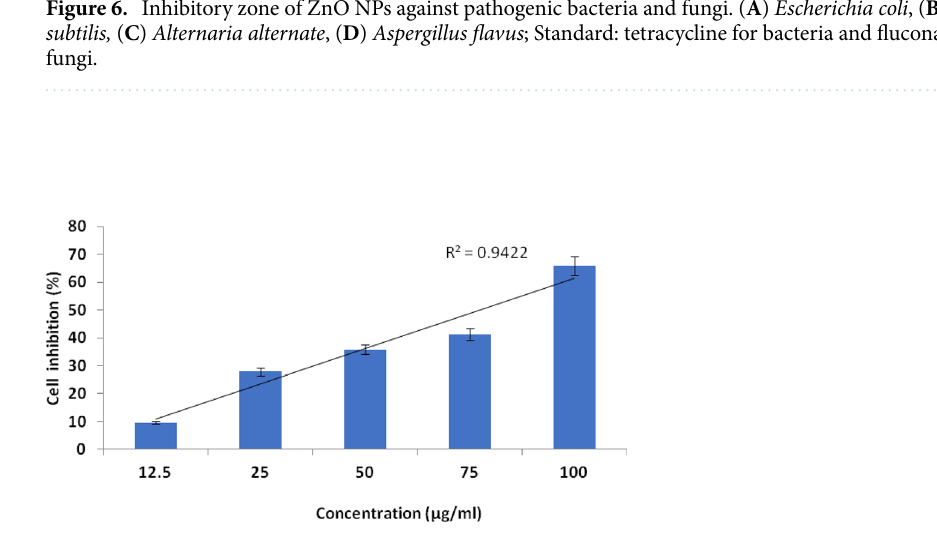
Figure 7. Cytotoxicity of Hep-G2 cancer cell lines mediated by synthesized ZnO NPs: cell growth inhibition (%); above each column, different letters indicate significant differences among treatments (ANOVA, Tukey’s HSD test , P < 0.05